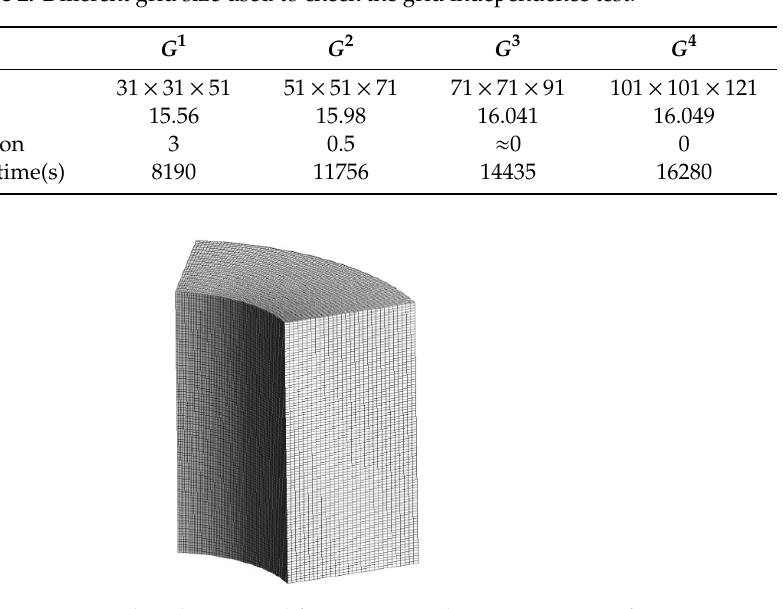
Figure 2. Structured grid generated for a cavity with an aspect ratio of 2.